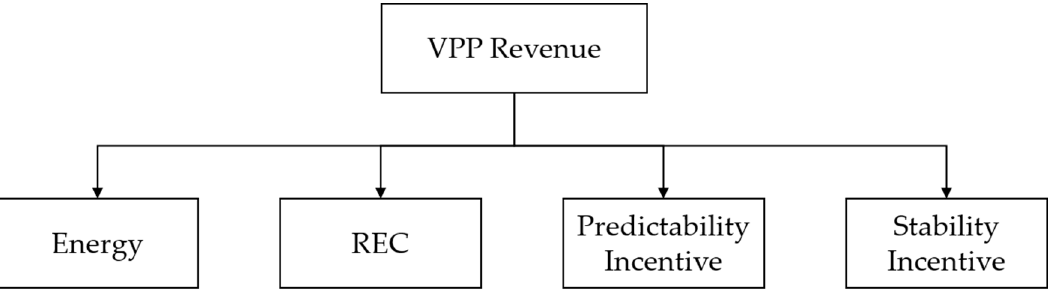
Figure 1. VPP revenue under the electricity market of a smart city.